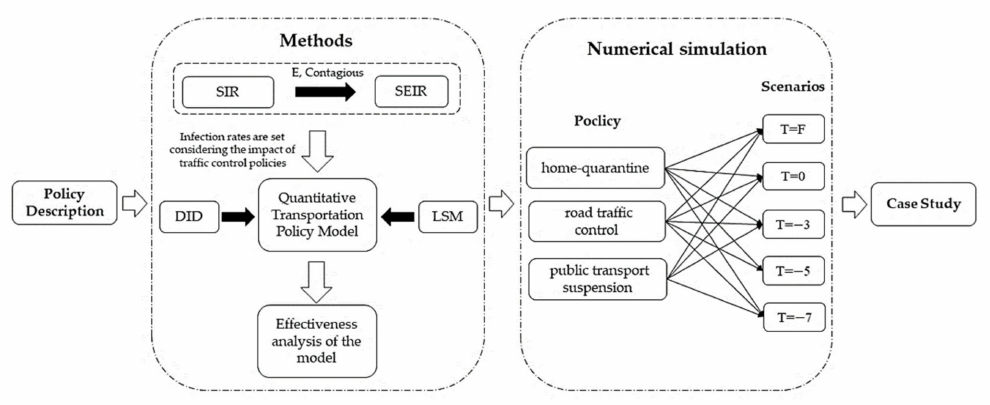
Figure 1. The research method